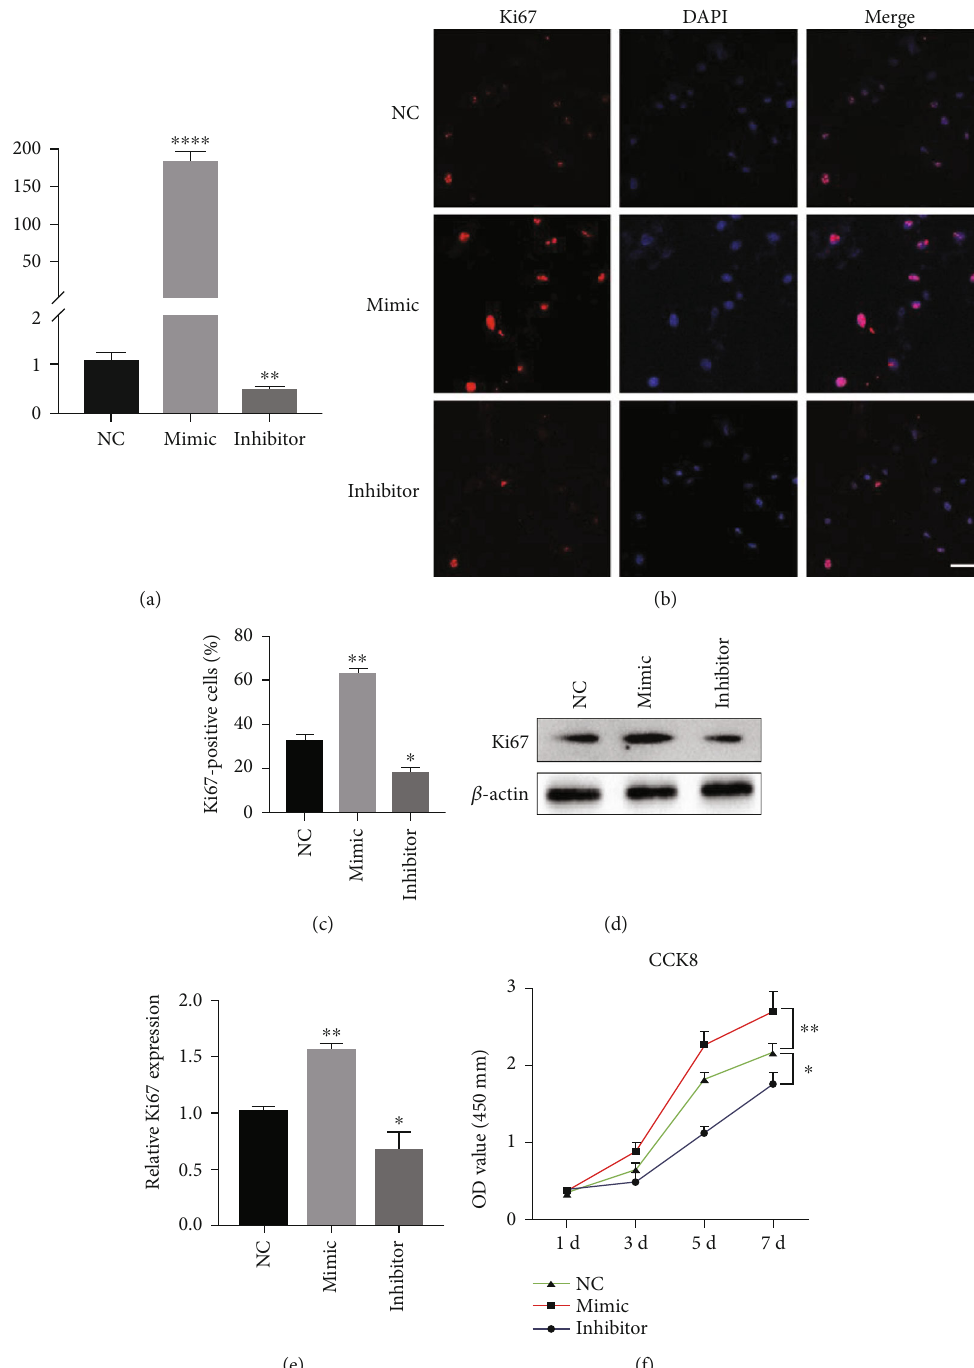
Figure 2: miR-129-5p promoted cell proliferation and migration. BMSCs were transduced with a lentiviral vector containing miR-129-5p mimic, miR-129-5p inhibitor, or negative control (NC) lentivirus, respectively. 48 hours after transduction, cells were used for the following analysis. (a) miR-129-5p expression was examined by quantitative RT-PCR. (b) Immunostaining with Ki67 (red) antibody and DAPI (blue) in BMSCs. Scale bars, 40 μ m. (c) Quanti fi cation of Ki67-positive cells in analysis was shown at (b) ( n = 4 ). (d) Western blot analysis showed the expression of Ki67. (e) Quanti fi cation of Ki67 protein levels was shown at (d). (f) Cell viability was estimated with CCK-8 assay at days 1, 3, 5, and 7. (g) Images were taken at 0h and 24h after scratch wound. (h) Histograms represent relative wound width at 24h normalized to that at 0h. Values represent means ± SD of at least three independent experiments. All p values were based on a two-tailed t -test. ∗ p < 0 : 05 and ∗∗ p < 0 : 01